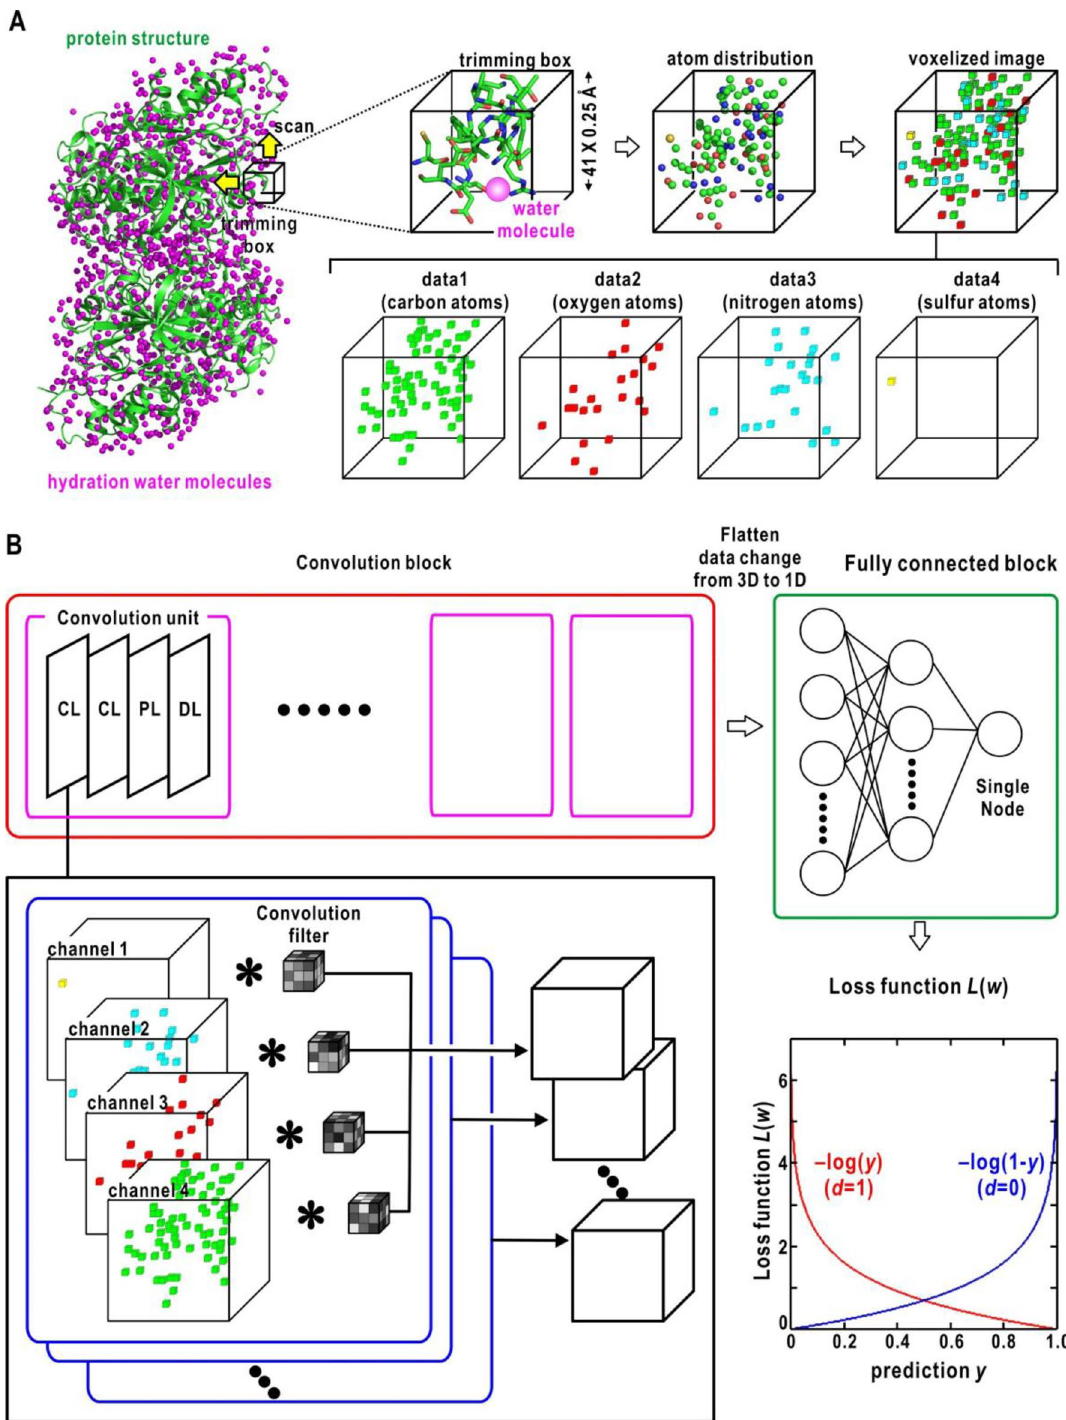
Figure 1. Construction of the NN to predict hydration probability around protein molecules. ( A ) Schematic of the preparation procedure for the dataset from crystal structures of proteins accompanying hydration water molecules. ( B ) Schematic of the NN architecture. The loss function is illustrated in the lower right The predicted probability tended to be higher for hydration sites with a greater number of interactions with protein atoms and adjoining hydration water molecules (Fig. 2D). This tendency was clear in the inside class, where greater number of interactions are expected than the first-layer class. In addition, at the crystal-water sites occupied by unambiguously identified hydration water molecules with the B-factors smaller than 30 Å 2 , the predicted hydration probability tended to be greater than 80% (Fig. 2E). Therefore, based on the frequency